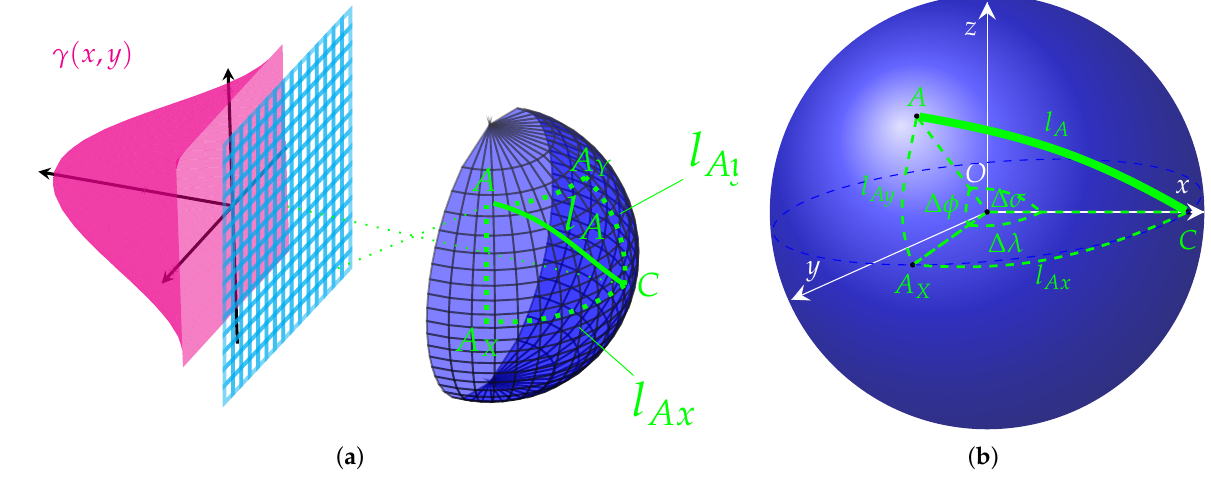
Figure 2. The principle for contrast compensation determination in 3D space: ( a ) spherical mapping of the retina to 2D image domain with correction function γ ( x , y ) , ( b ) great-circle distance.